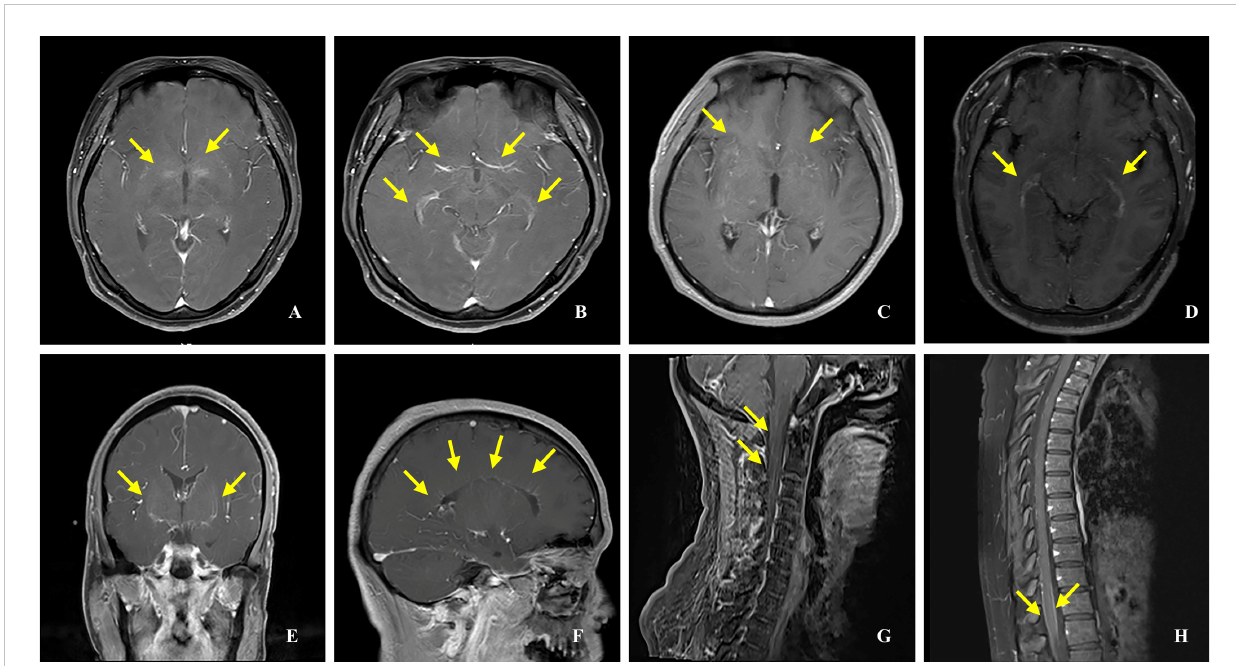
FIGURE 3 Gadolinium enhancement MRI in patients with anti-GFAP antibodies. (A, C) Punctate enhancement lesions. (B, D) Periependymal enhancement. (E) Linear enhancement of the cerebellum. (F) Linear enhancement perpendicular to the ventricle. (G) Linear enhancement of the spinal cord. (H) Enhancement of the spinal cord